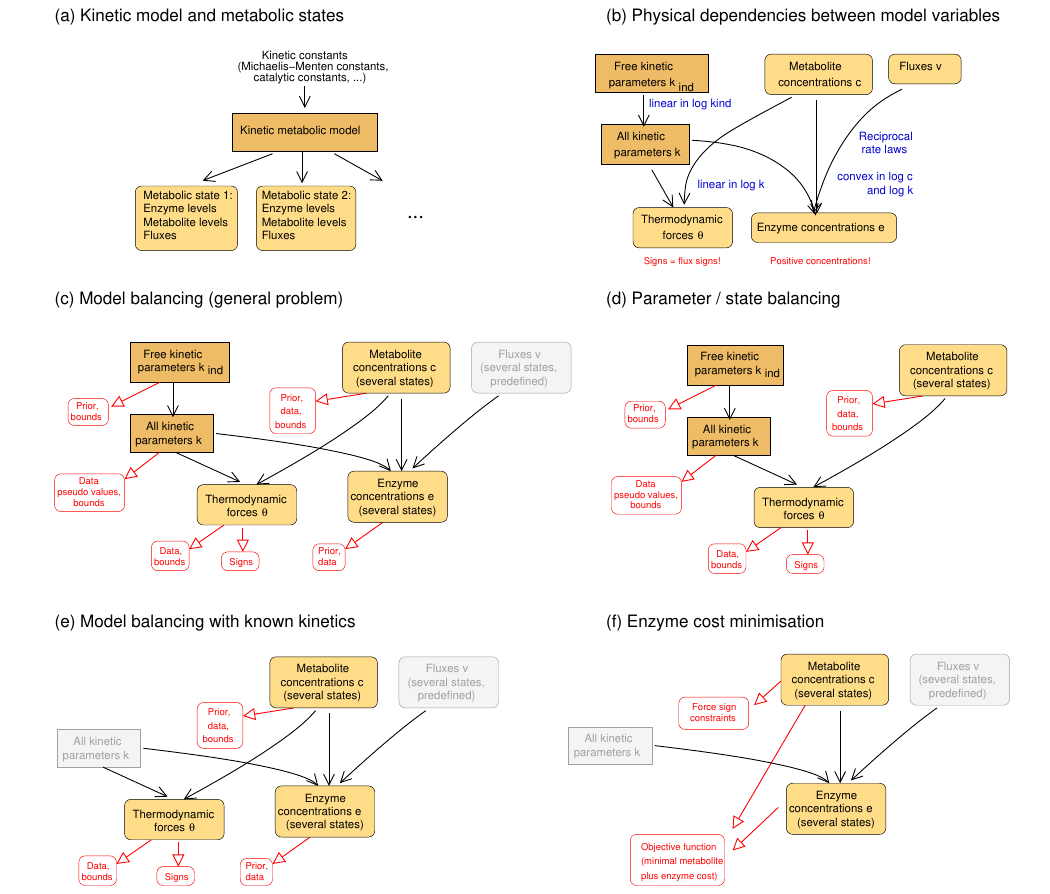
Figure 6. Estimation methods for kinetic constants and metabolic states. ( a ) Kinetic model and metabolic states. A model is parameterised by kinetic constants (e.g., equilibrium constants, catalytic constants, and Michaelis–Menten constants) and is used to generate a number of metabolic states (characterised by enzyme concentrations, metabolite concentrations, and fluxes). States may be stationary (with steady-state fluxes) or not (e.g., states during dynamic time courses); ( b ) dependencies between kinetic constants and state variables (see Figure 1); ( c ) model balancing. Kinetic constants and metabolite concentrations (for several states) are the free variables of a statistical model. Dependent kinetic constants, thermodynamic driving forces, and enzyme concentrations (bottom) are the dependent variables, and fluxes (top right) are predefined. Priors and data may be used in the estimation. The other graphics show ( d ) parameter balancing [21,24] for kinetic data and metabolite concentrations; ( e ) model balancing with given kinetic constants; ( f ) enzyme cost minimisation [43], in which enzyme and metabolite concentrations are optimised for a low enzyme and metabolite